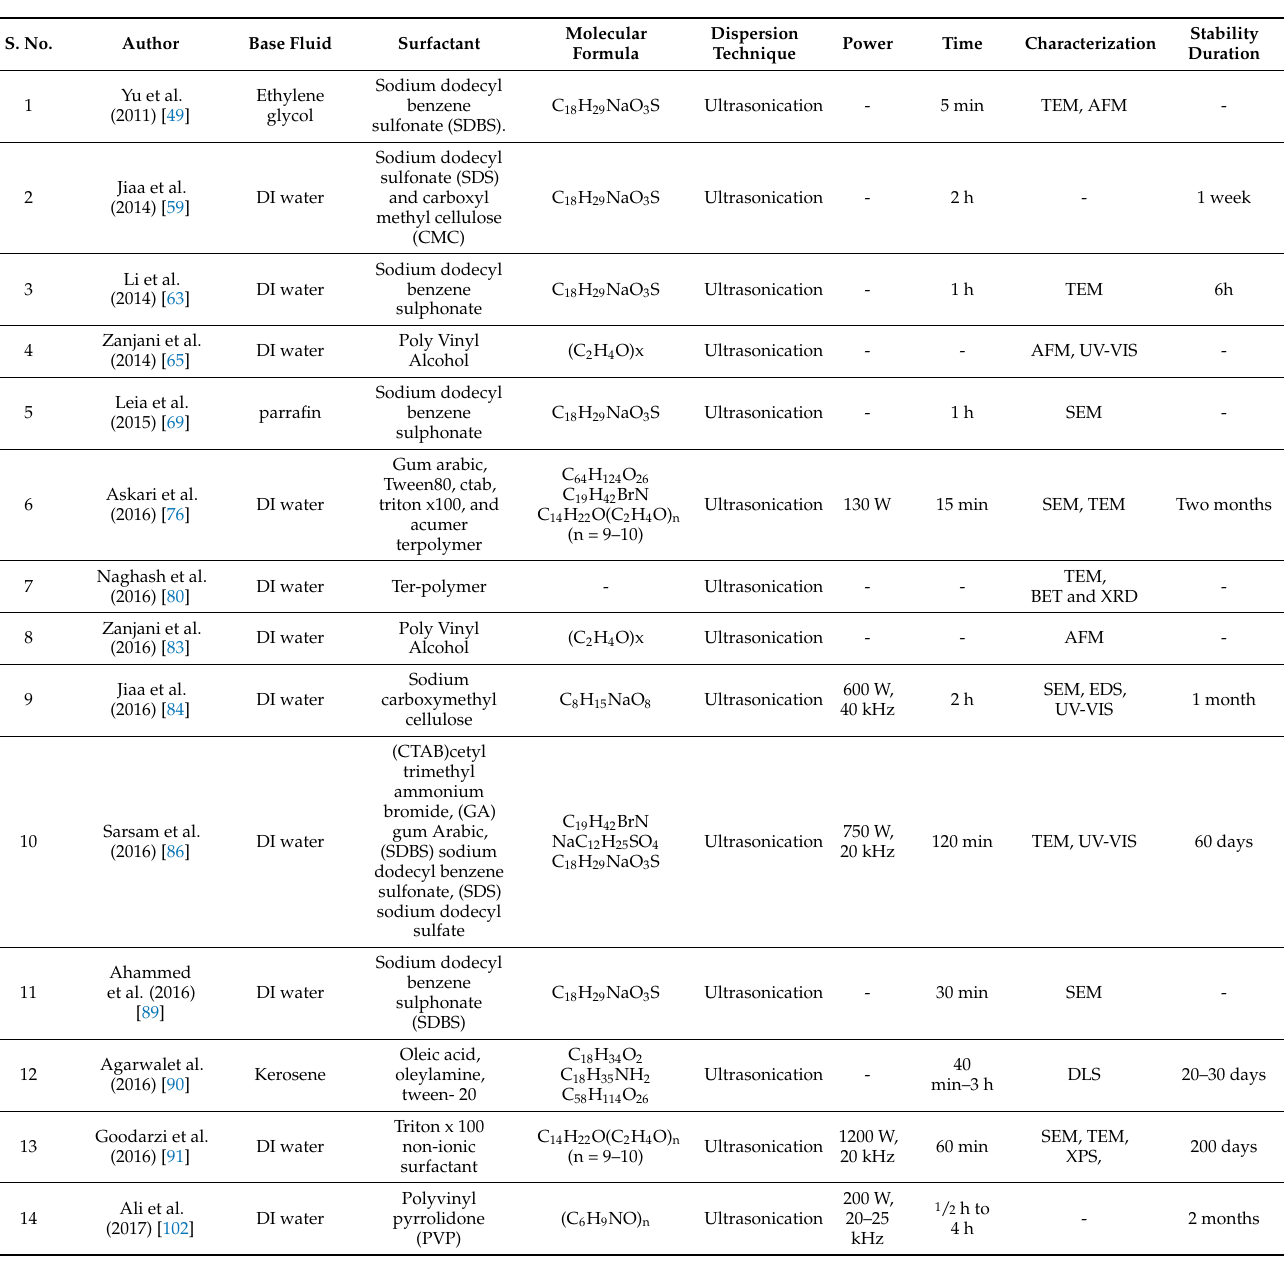
Table 6. Summary of published literature on synthesis of graphene nanofluids by non- covalent